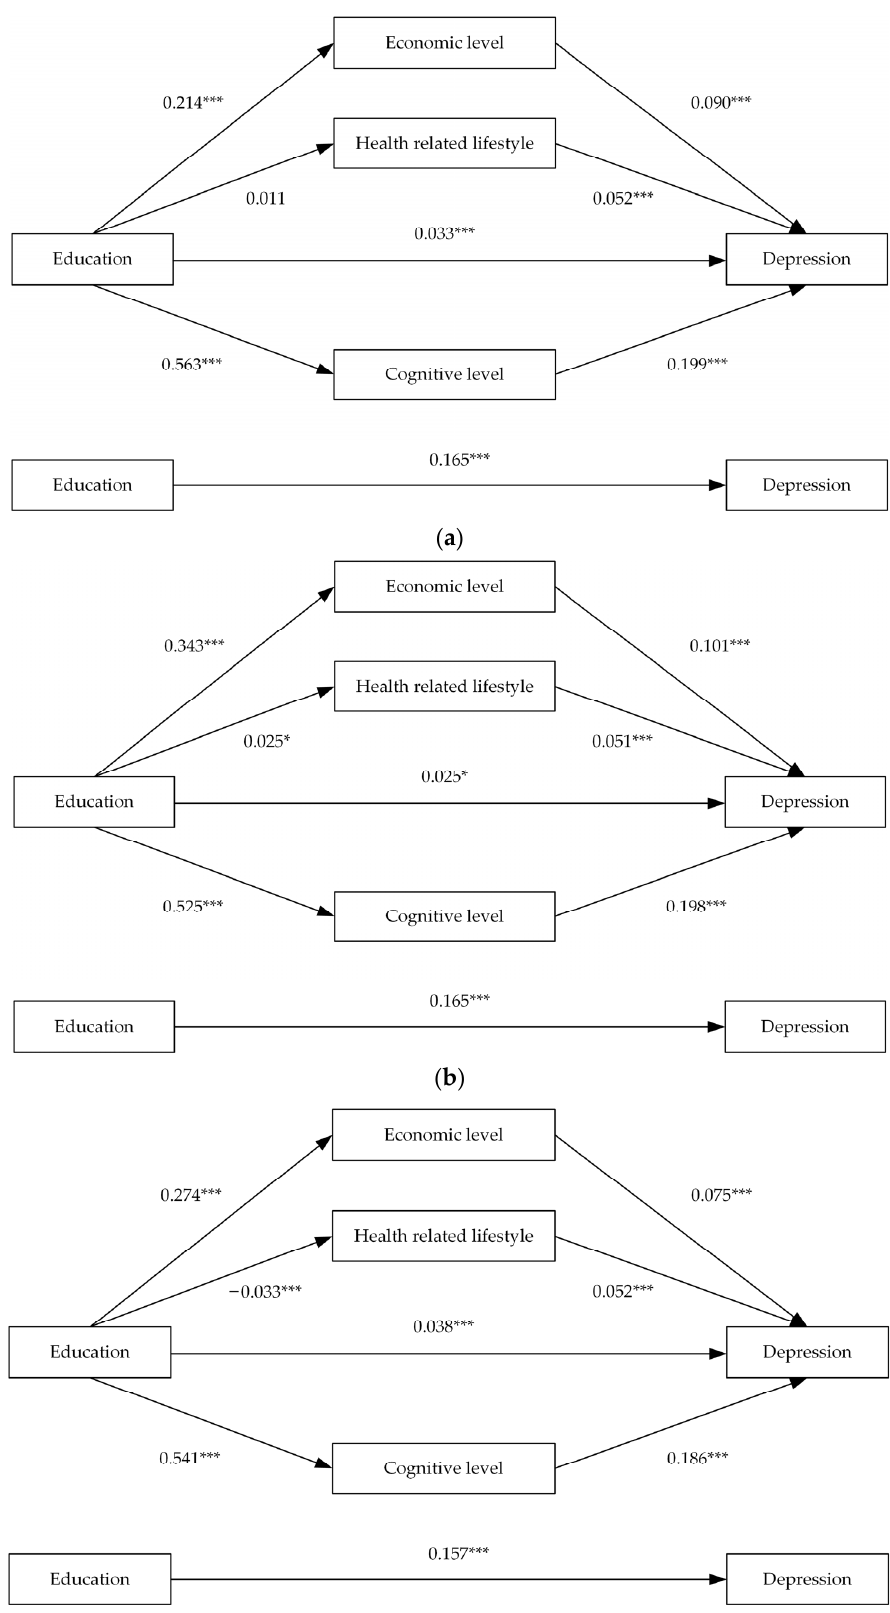
Figure 3. Results of multiple mediation analysis. ( a ) All samples; ( b ) Middle-aged samples; ( c ) Elderly samples. *** represents p ‐ value < 0.01, * represents p ‐ value < 0.1 .